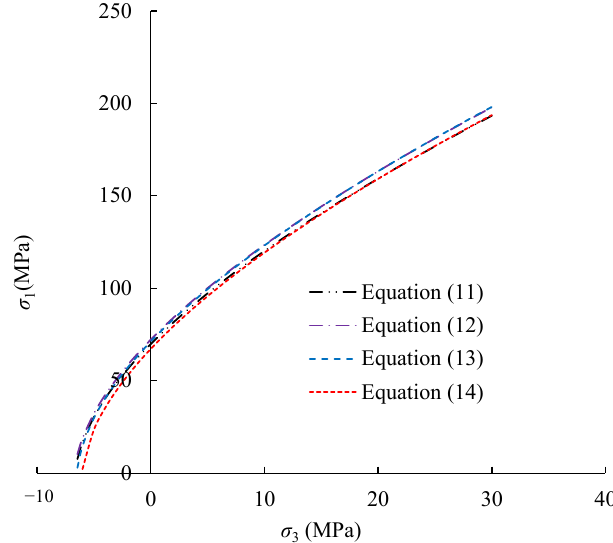
Figure 12. The Hoek-Brown failure envelope using different fitness functions.